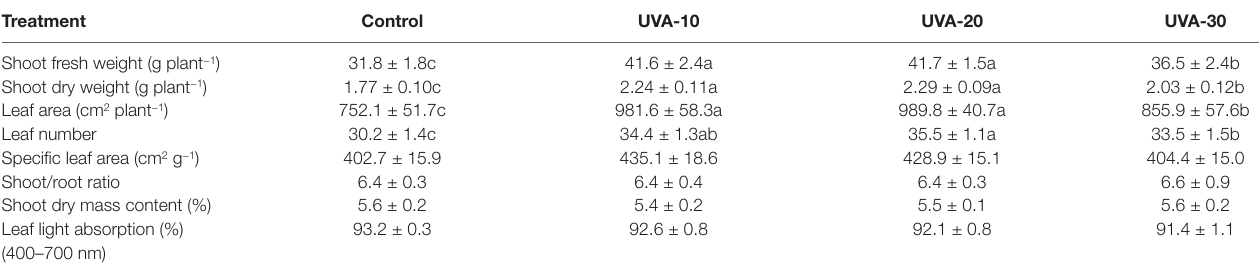
TABLe 2 | Plant growth and morphology in response to different UVA intensities. Treatment